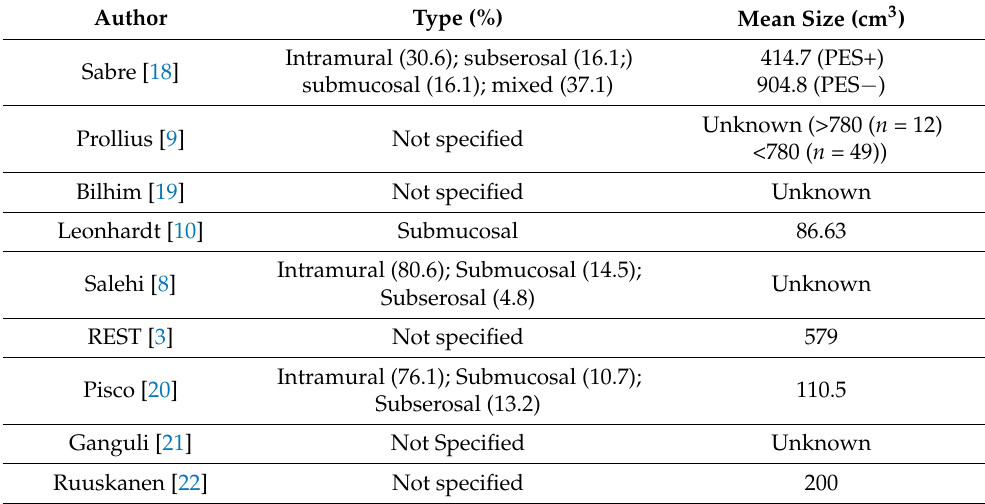
Table 3. Characteristics of